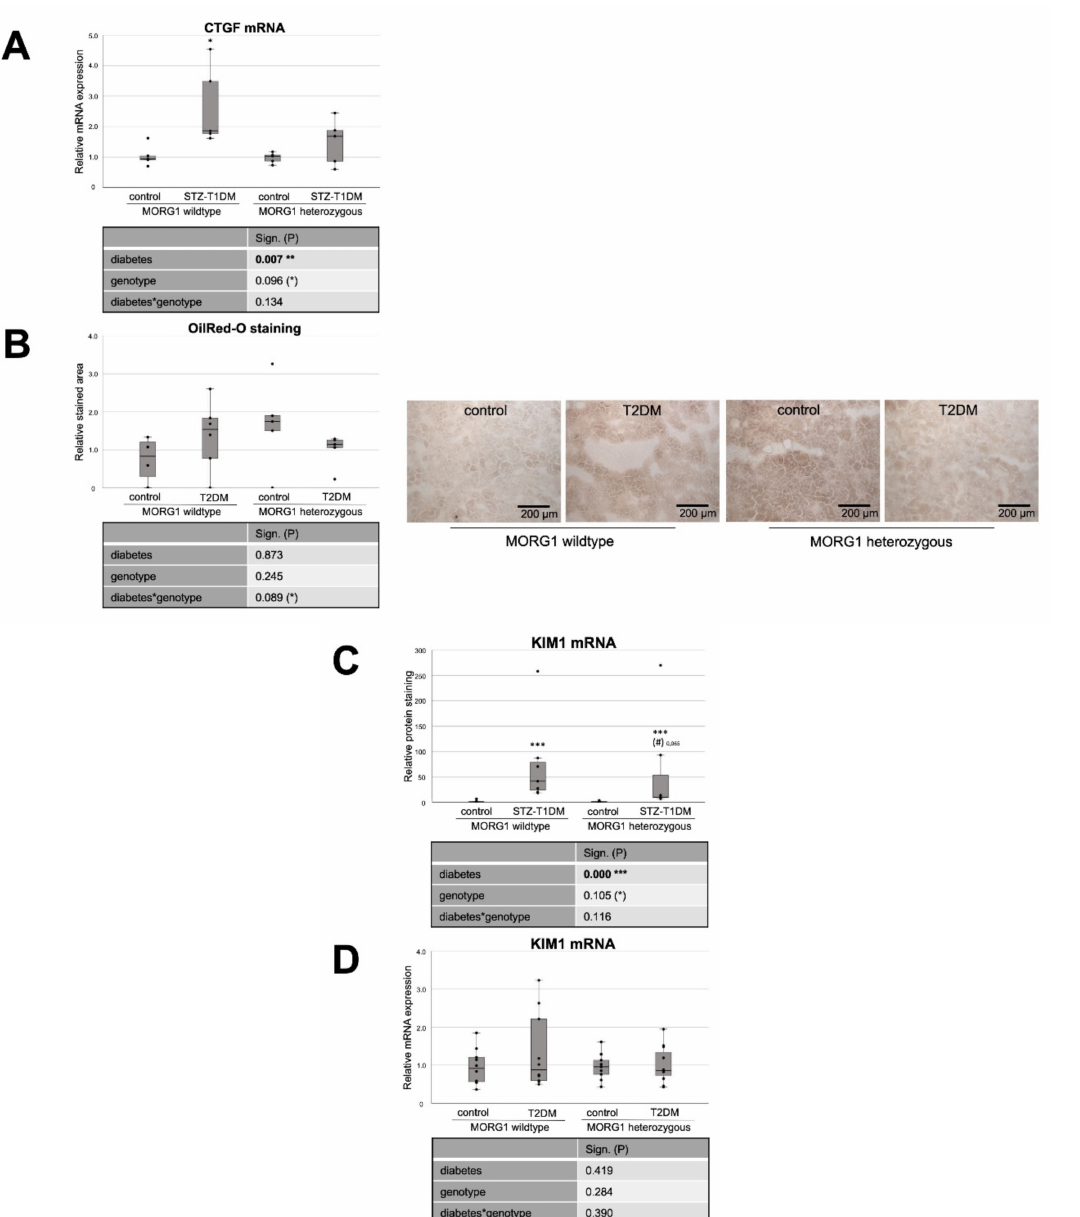
Figure 6. Effect of diabetes and MORG1 on TIF and lipid accumulation. ( A ) Real-time analysis of CTGF (connective tissue growth factor) mRNA expression in STZ-T1DM. ( B ) Quantitative analysis of OilRedO staining of kidney sections from T2DM animals (graph) and representative images next to the graph (magnification × 100). ( C , D ) Real-time analysis of KIM1 (kidney injury molecule-1) mRNA expression in STZ-T1DM and T2DM ( A – D ) The significances shown in the tables were assessed by two-way ANOVA with diabetes (control or STZ-T1DM/T2DM) and genotype (MORG1 wild-type or MORG1 heterozygous) as the two factors. Diabetes, genotype: main effect of diabetes/genotype, respectively. Diabetes*genotype: interaction. Bold: statistically significant. (*) Biologically relevant. Significances shown next to each bar were assessed by using Mann–Whitney U test; * p ≤ 0.05 in between same genotype; *** p ≤ 0.001 in between same genotype; (#) biological relevant in between different